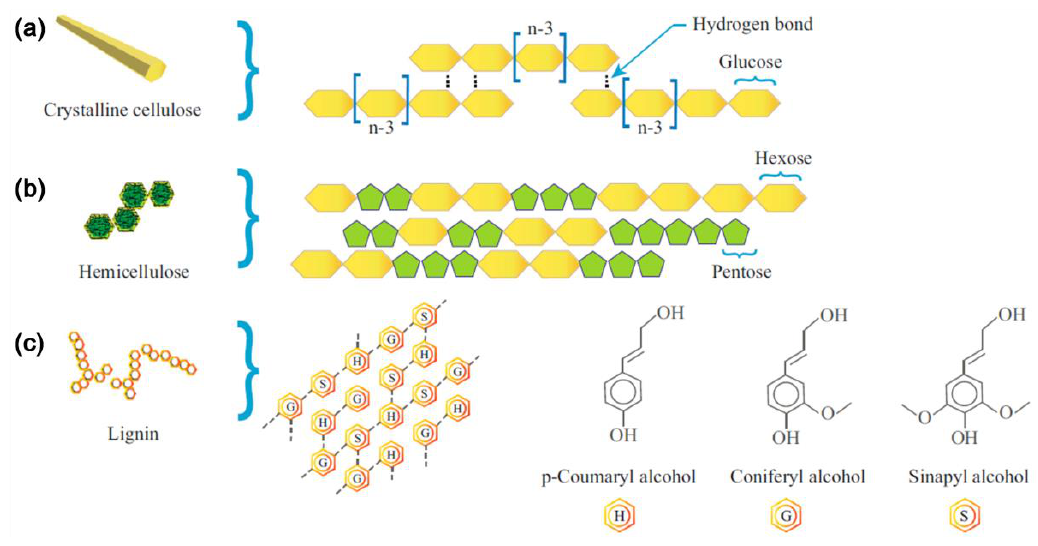
Figure 2. Chemical structures of ( a ) cellulose, ( b ) hemicellulose and ( c ) lignin with the monomeric units of lignin macromolecules labeled as H, G and S. Reproduced from [49], with the permission from Springer Nature, 2015.